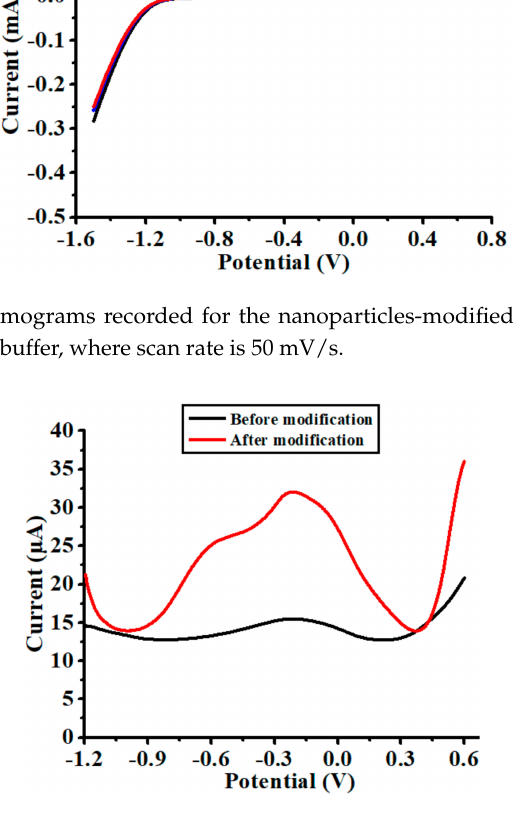
Figure 4. Anodic stripping voltammograms recorded for the chemical sensor before and after modification in the solution of 20 µ g/L Cd(II) with 0.1 M acetate buffer, where deposition potential is − 0.7 V and deposition time is 60